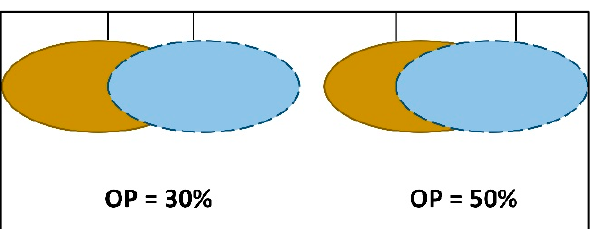
Figure 2. Schematics representing ( a ) prismatic block; ( b ) beads’ building tool path strategy; and ( c ) picture of the as-WAAM-ed blocks.